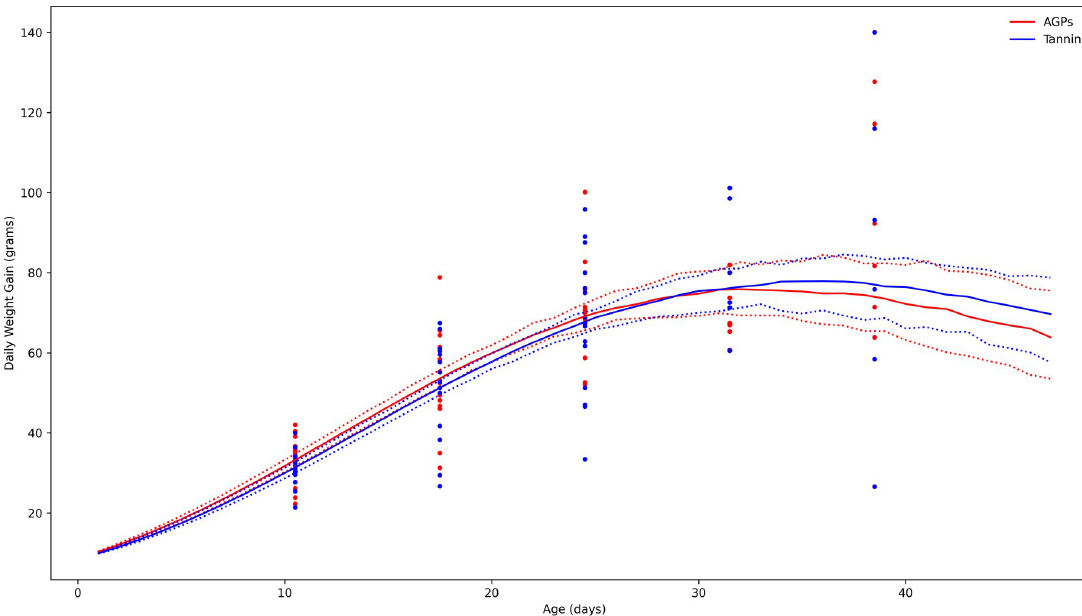
Fig 2. Daily weight gain derived from Gompertz equation. Solid lines represent estimated mean daily weight gains at different ages (R � Wf) for tannins (blue) and AGPs (red) treated flocks, dotted lines represents CI at 95% for the growth curve after 100000 montecarlo simulations. Circles represent average daily gains estimated from observed weekly weights (see Table